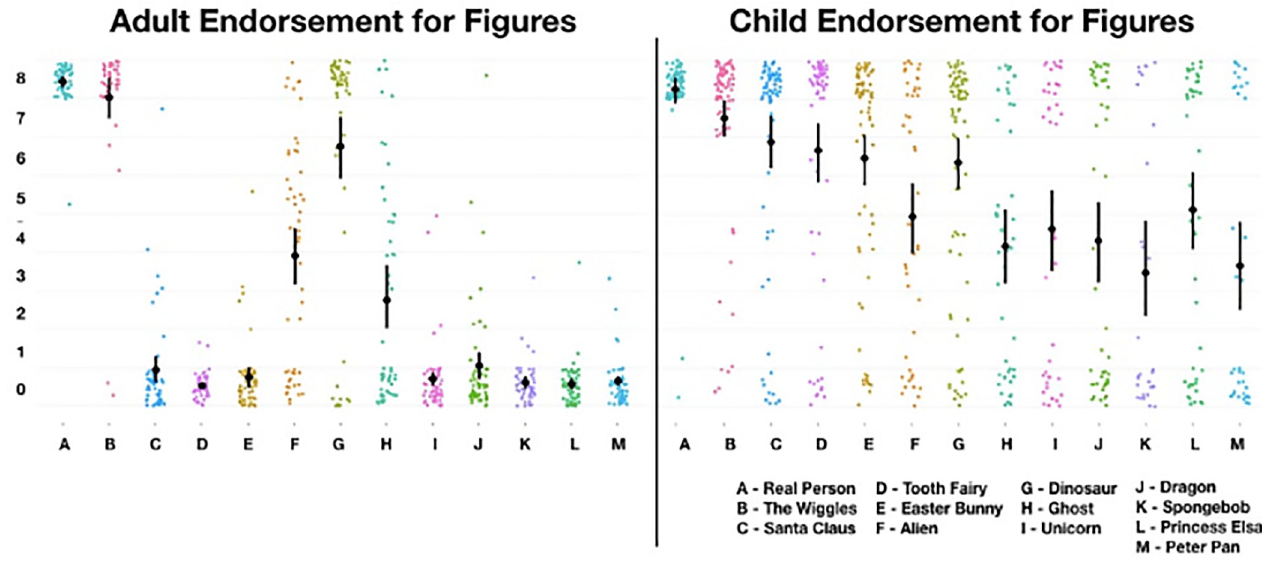
Fig 5. Endorsement for figures for adults and children. Note: Child Figure is a reprint of Fig 3.